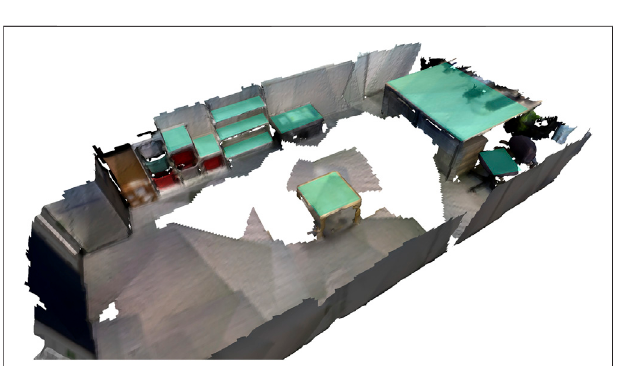
FIGURE 6 | Reconstruction of the room used for the real robot experiments. The detected planes are highlighted in